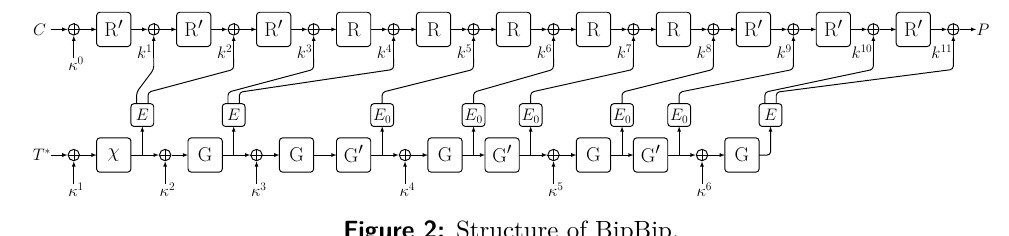
Figure 2: Structure of